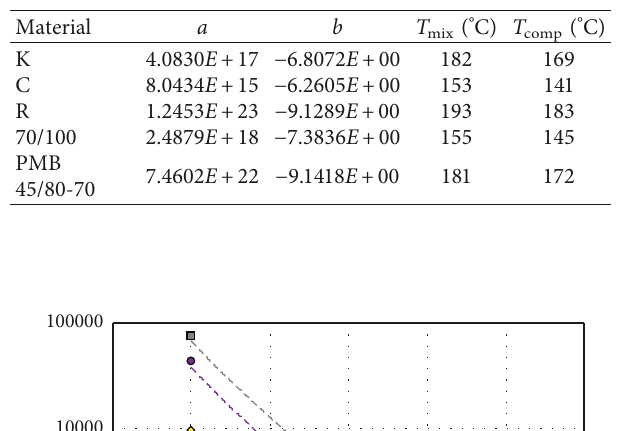
Table 2: Mixing and compaction temperatures of selected binders.